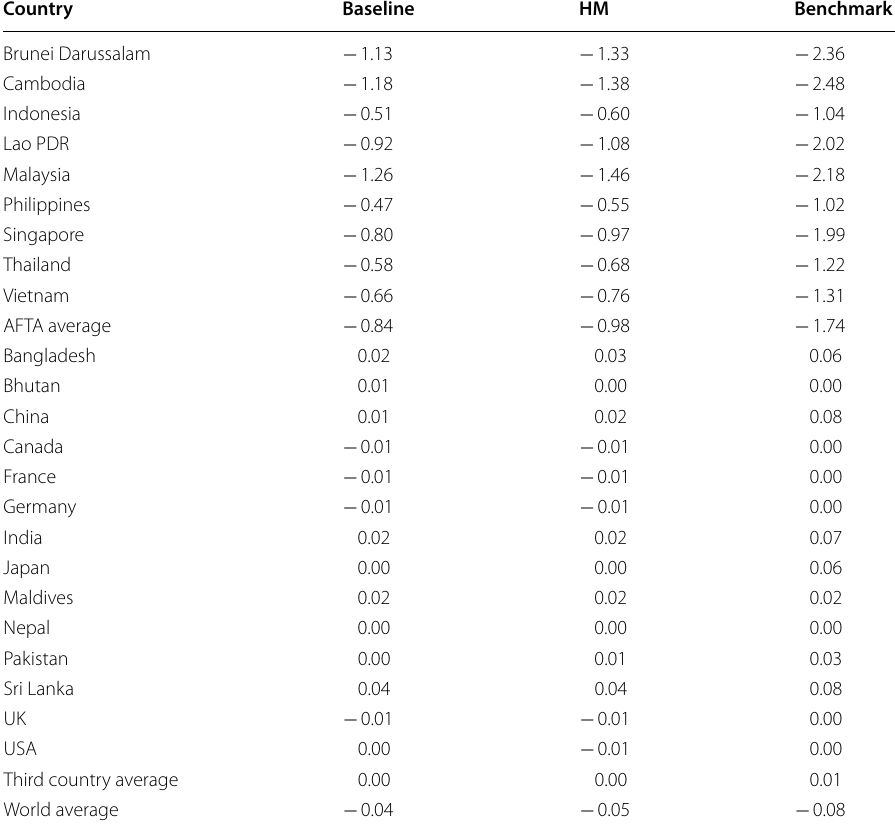
Table 3 Conditional GE of AFTA, measures from the changes in real GDP. Source Authors’